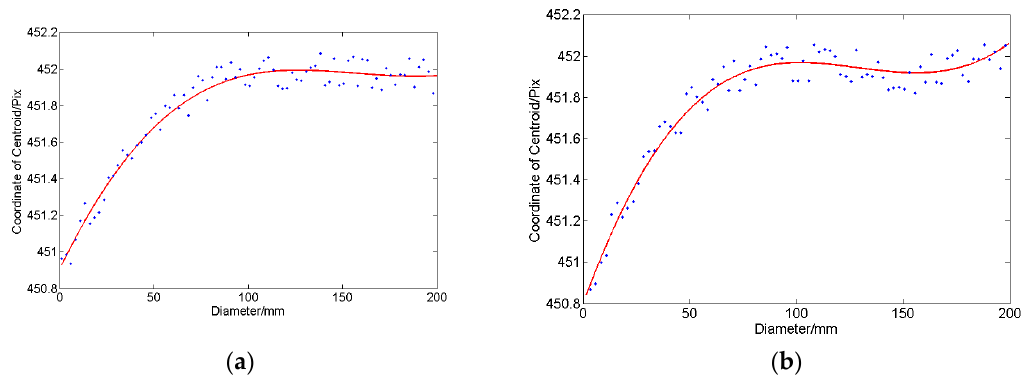
Figure 4. Wavefront fitting results with ( a ) pre-compensated data and ( b ) post-compensated data.